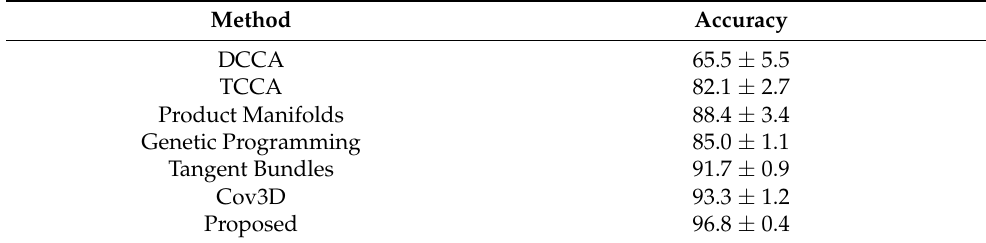
Table 2. The recognition accuracy on Sebastien Marcel Dynamic Hand Posture Dataset.